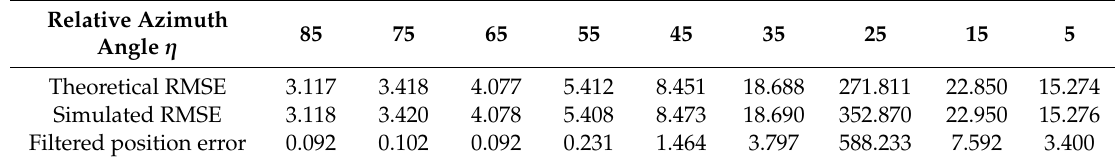
Table 2. Positioning results of Scenario 2.